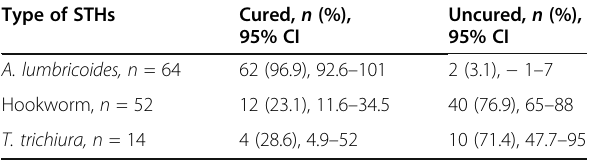
Table 1 Cure rates (CR) and 95% of CI of CR of mebendazole against STHs among schoolchildren in Northwest Ethiopia, 2018 hookworms (Mrus 2018). Similarly, a meta-analysis of randomized controlled trials across many different Type of STHs Cured, n (%), 95% CI countries (55 trials for cure rates and 46 trials for egg reduction rates) showed mebendazole to have much lower efficacy against hookworms than did albenda- zole: overall cure rates were 32.5% (95% confidence interval 20.8 to 46.9%) and 79.5% (95% confidence interval 71.5 to 85.6%) and overall egg reduction rates were 61.0% (95% confidence interval 52.0 to 69.9%)